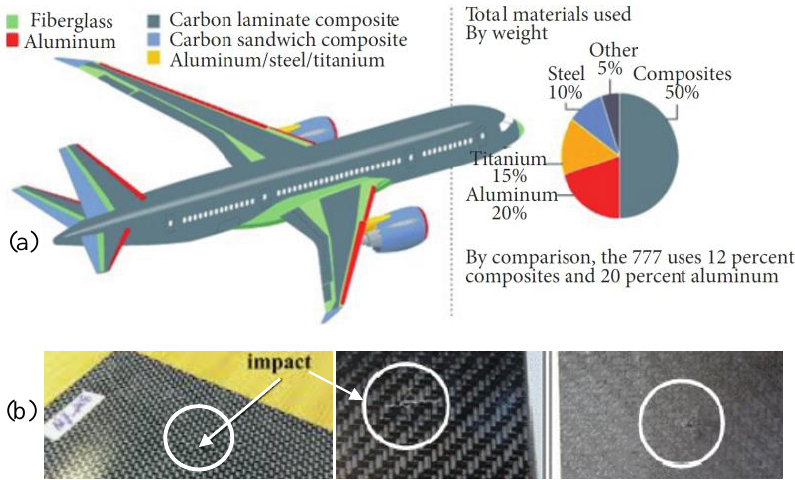
Figure 1. Demo of CFRP application and impact damages. ( a ) Materials used in a Boeing 787 body [2]; ( b ) The barely visible impact damages [5,6].